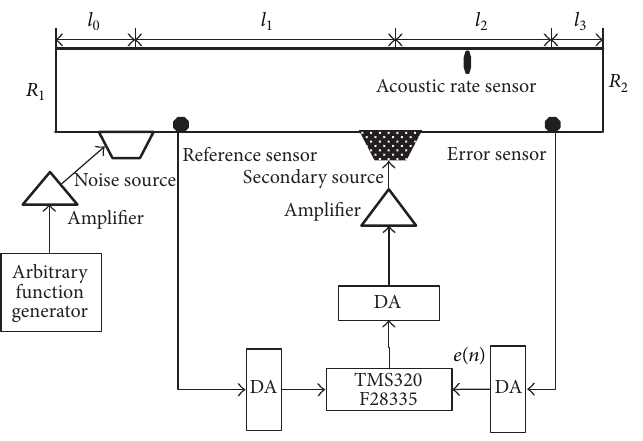
Figure 5: Experimental platform setup.